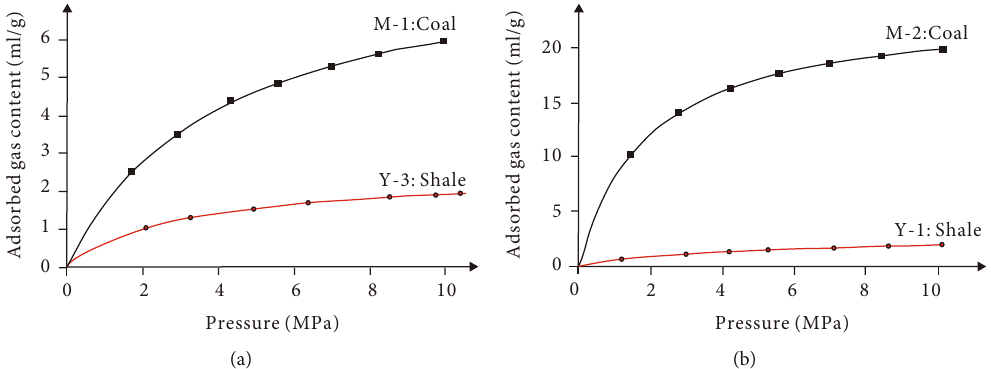
= 0 : 56 % and Y-3, R = 0 : 58 % , shale; and (b) M-2, o o